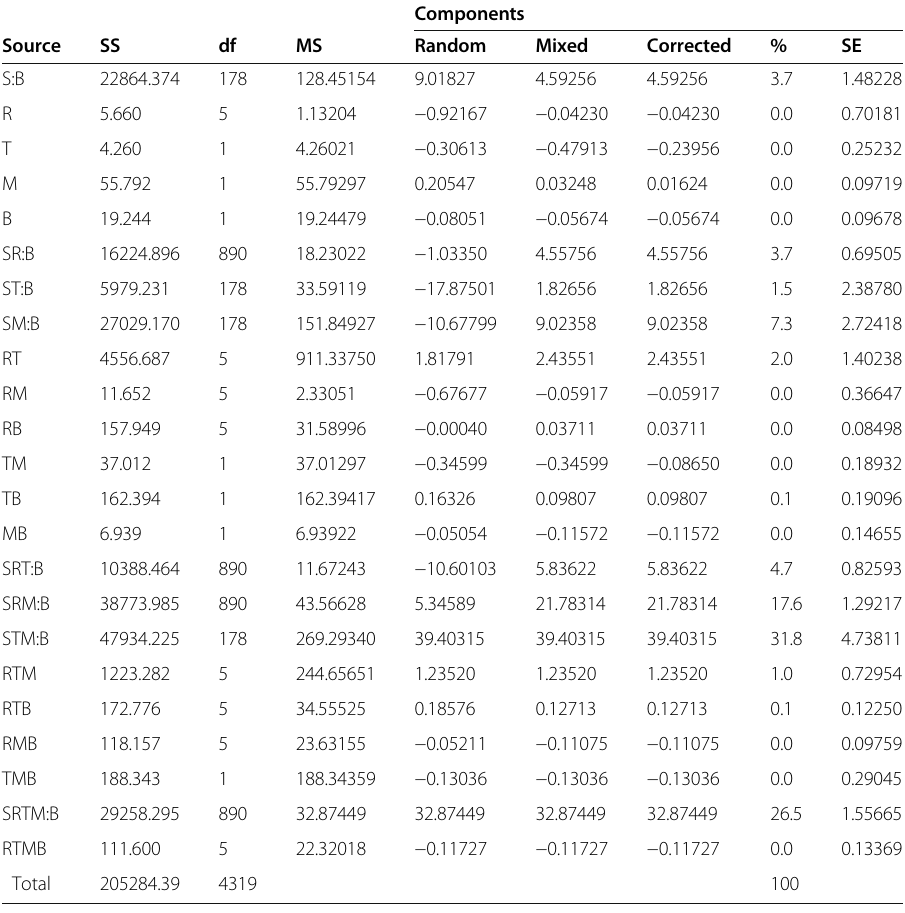
Table 4 Analysis of variance (ANOVA)